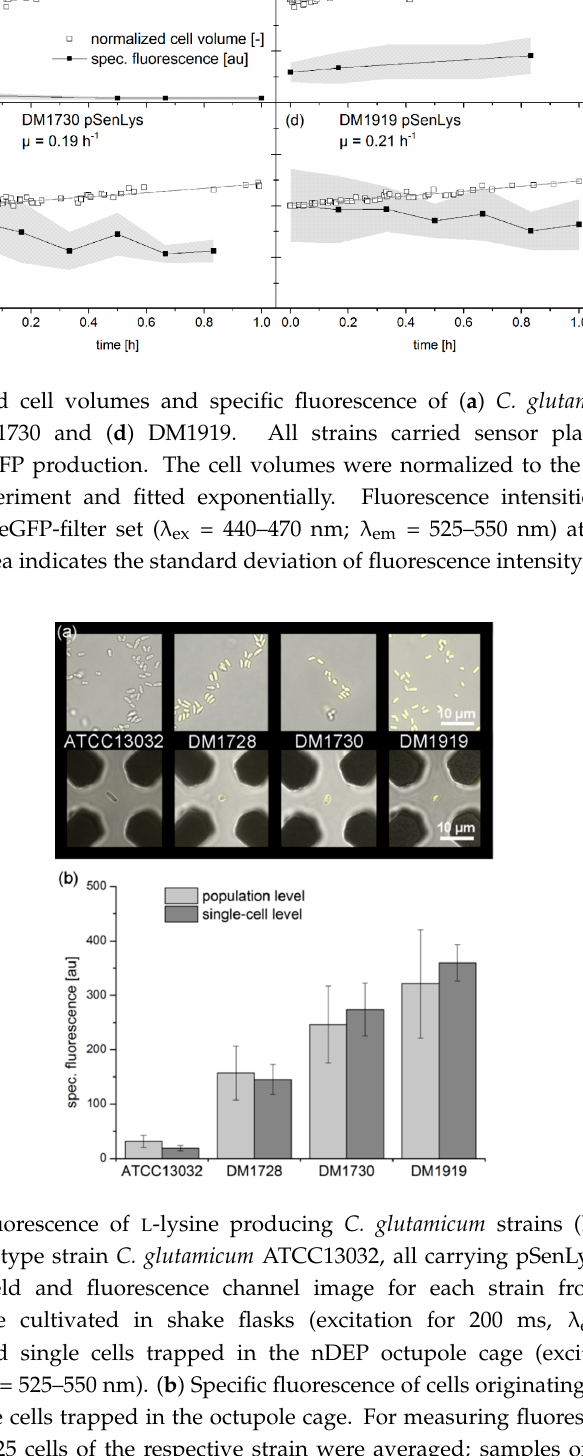
(Figure 8a) and of around 0.21 h − 1 for the three L -lysine producer strains ( C. glutamicum DM1728: 0.23 h − 1 , DM1730: 0.19 h − 1 , DM1919: 0.21 h − 1 ) (Figure 8b–d). The comparison of specific growth rates of C. glutamicum DM1730 pSenLys in the nDEP octupole with (Figure 8b) and without fluorescence excitation (Figure 7) revealed a decrease of 63%. This decrease was triggered by exposing the cells to fluorescent excitation every 10 min. The production of reactive oxygen species, upon eYFP excitation, could lead to light-induced damage of proteins, nucleic acids or membrane lipids and altered cell physiology [53,54]. That explained the reduction in growth rate of C. glutamicum DM1730 pSenLys cells exposed to fluorescence excitation. Specific growth rates of population-based cultivations in shake flasks were the same for C. glutamicum ATCC13032 pSenLys (0.45 h − 1 ± 0.02) and around twice as high as for single-cell cultivation for the L -lysine producing strains ( C. glutamicum DM1728: 0.45 h − 1 ± 0.01, DM1730: 0.38 h − 1 ± 0.04, DM1919: 0.40 h − 1 ± 0.02). It can be